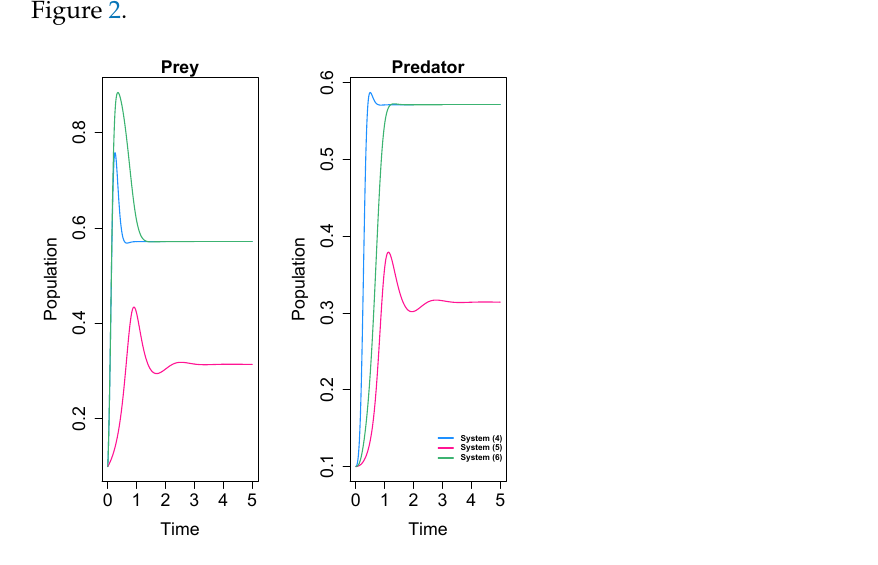
Figure 1. Time–population density of prey and predator for systems (4), (5) and (6). The initial conditions are x ( 0 ) = 0.1 and y ( 0 ) = 0.1, and the values for the parameters are r = 20, a = 15 and β = 0.6.